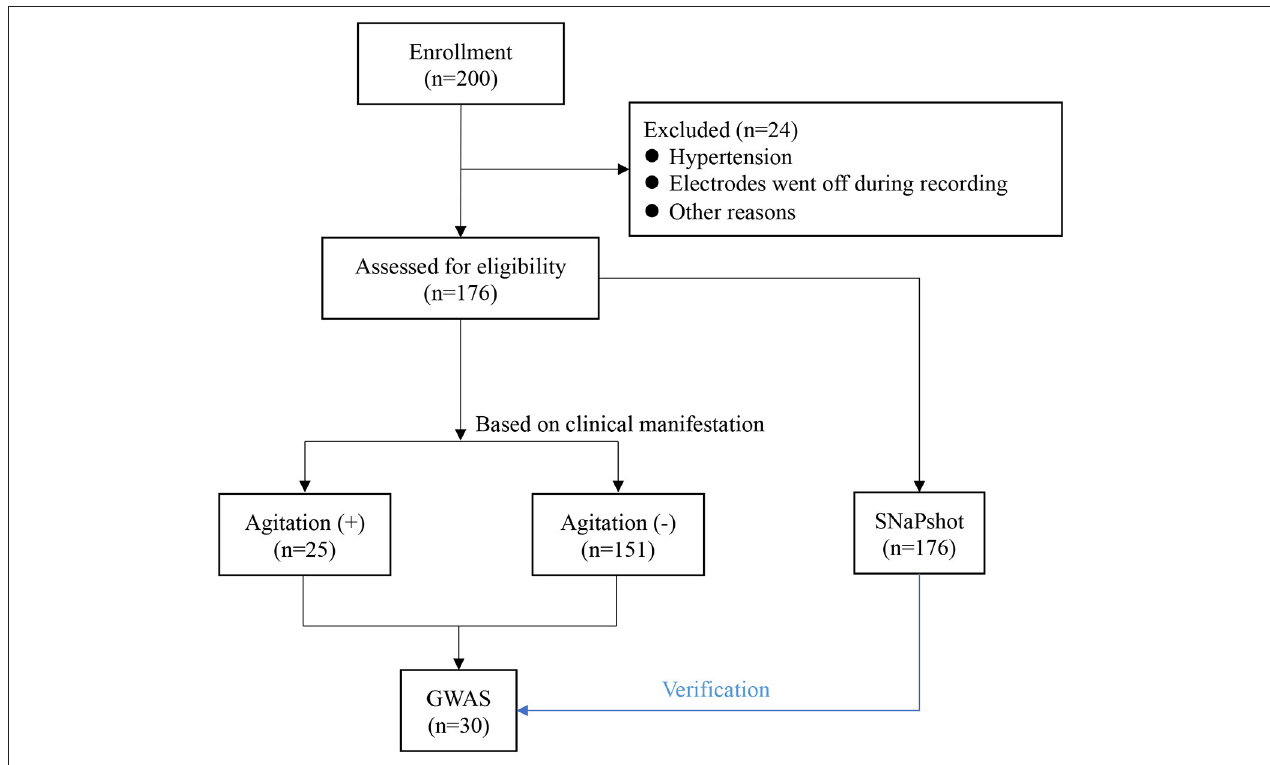
FIGURE 1 | Flow chart of the study design of this study. GWAS, genome-wide association